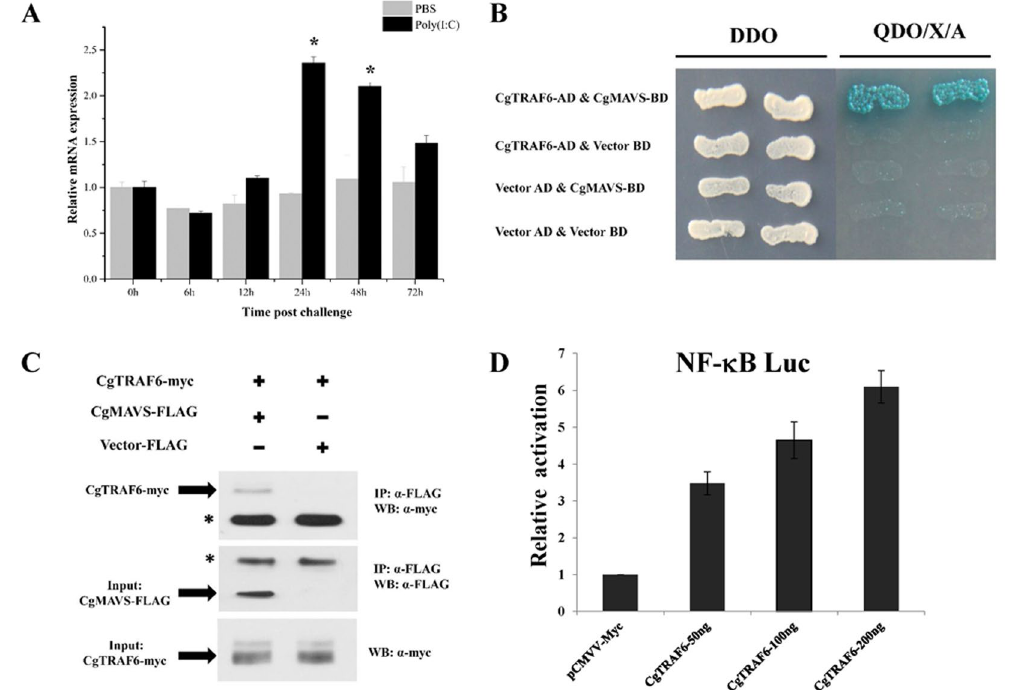
Figure 6. CgTRAF6 interacts with CgMAVS and specifically activates the NF- κ B pathway. ( A ) Expression profile of CgTRAF6 after poly(I:C) challenge determined by qRT-PCR. ( B and C ) Interaction between CgTRAF6 and CgMAVS detected by Y2H ( B ) and Co-IP ( C ). DDO: -Leu/-Trp double-dropout media, QDO/X/A: -Ade/-His/-Leu/-Trp quadruple-dropout media with X- α -Gal and aureobasidin. ( D ) CgTRAF6 specifically activated the NF- κ B promoter in a concentration-dependent manner. The activation was detected using dual luciferase reporter assays in human HEK293T